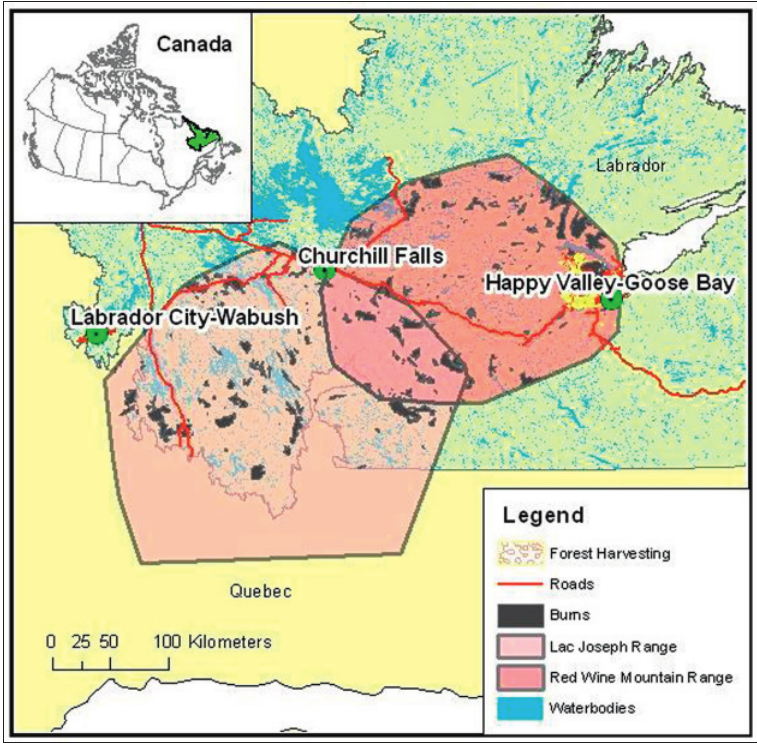
Fig. 1. Range boundaries of the Lac Joseph and Red Wine Mountain caribou popula-